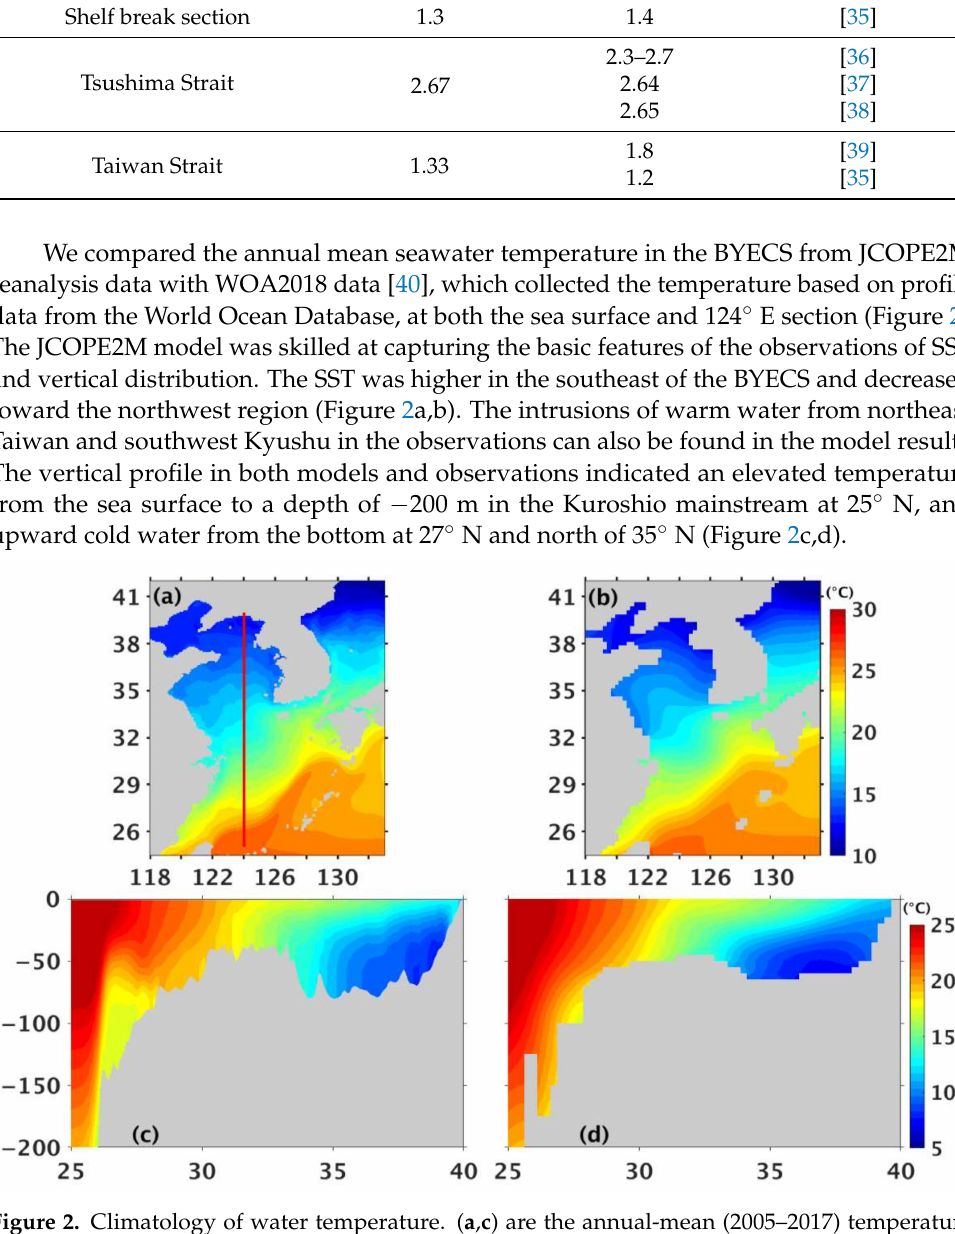
Figure 2. Climatology of water temperature. ( a , c ) are the annual-mean (2005–2017) temperature distributions at the sea surface and 124 ◦ E from the JCOPE2M reanalysis data, respectively. ( b , d ) are plots of the same, but from the WOA2018 dataset. The red line in ( a ) denotes the section at 124 ◦